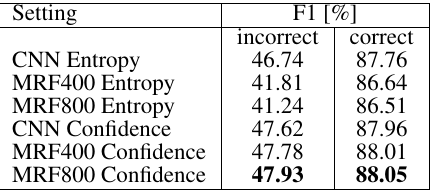
Table 3. F1 values for detection of misclassifications for 20%